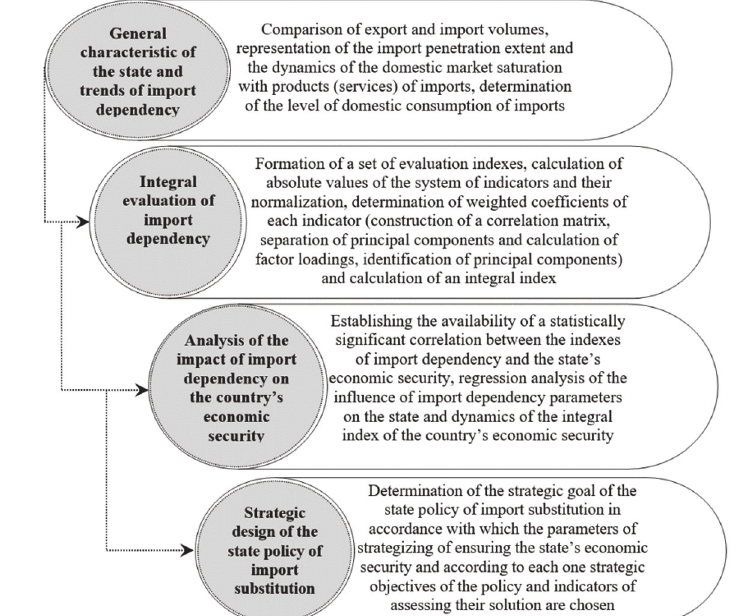
Fig. 1. Methodical sequence of the evaluation of import dependency, its impact on the state’s economic security and strategizing the import substitution state